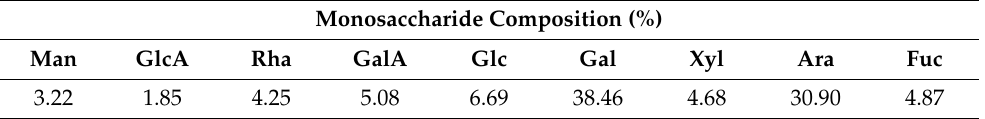
Table 1. Monosaccharide composition analysis.